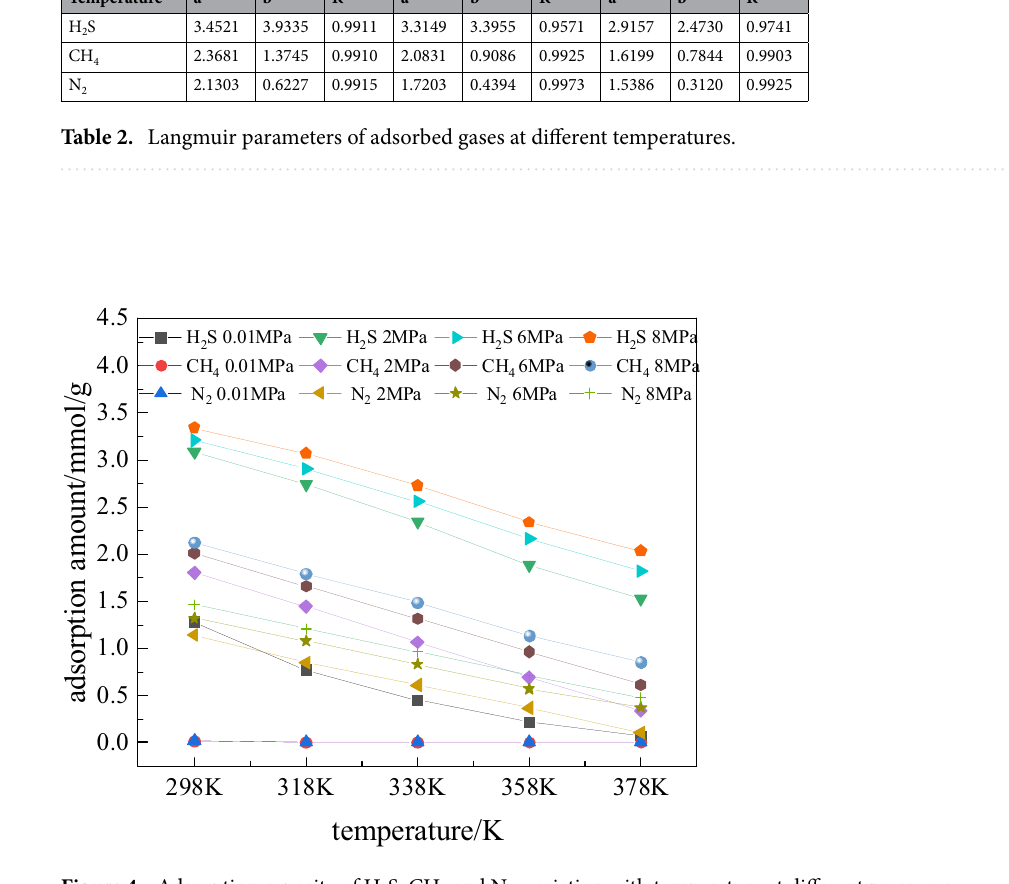
Figure 4. Adsorption capacity of H 2 S, CH 4 and N 2 : variation with temperature at different